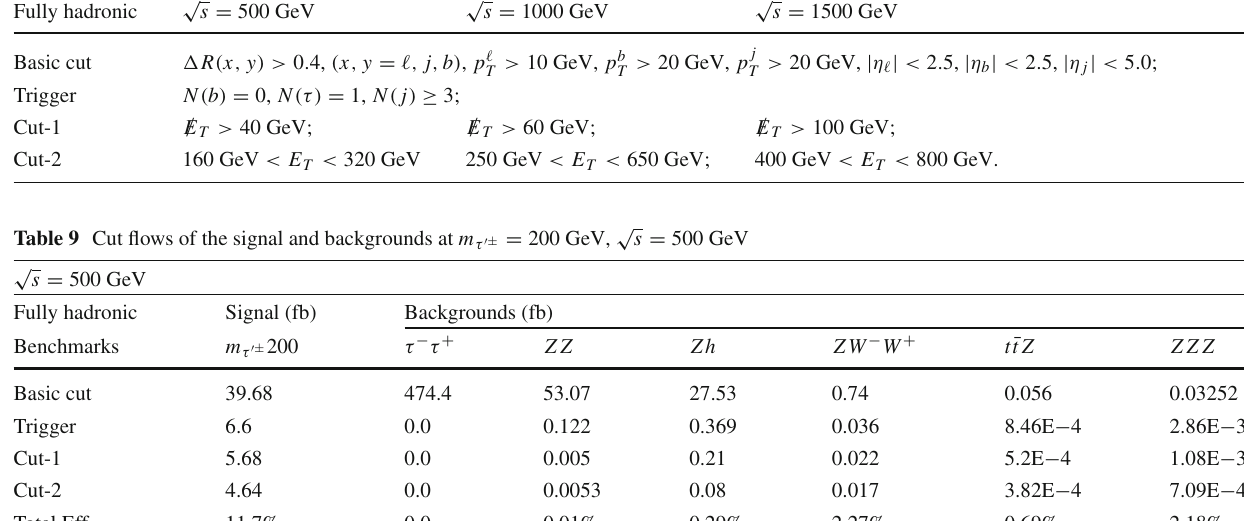
Fig. 9 Same as Fig. 7 but for normalized distributions of the / E T and E T of signal and backgrounds in fully hadronic channel at Table 8 Same as Table 3 but for fully hadronic channel Fully hadronic